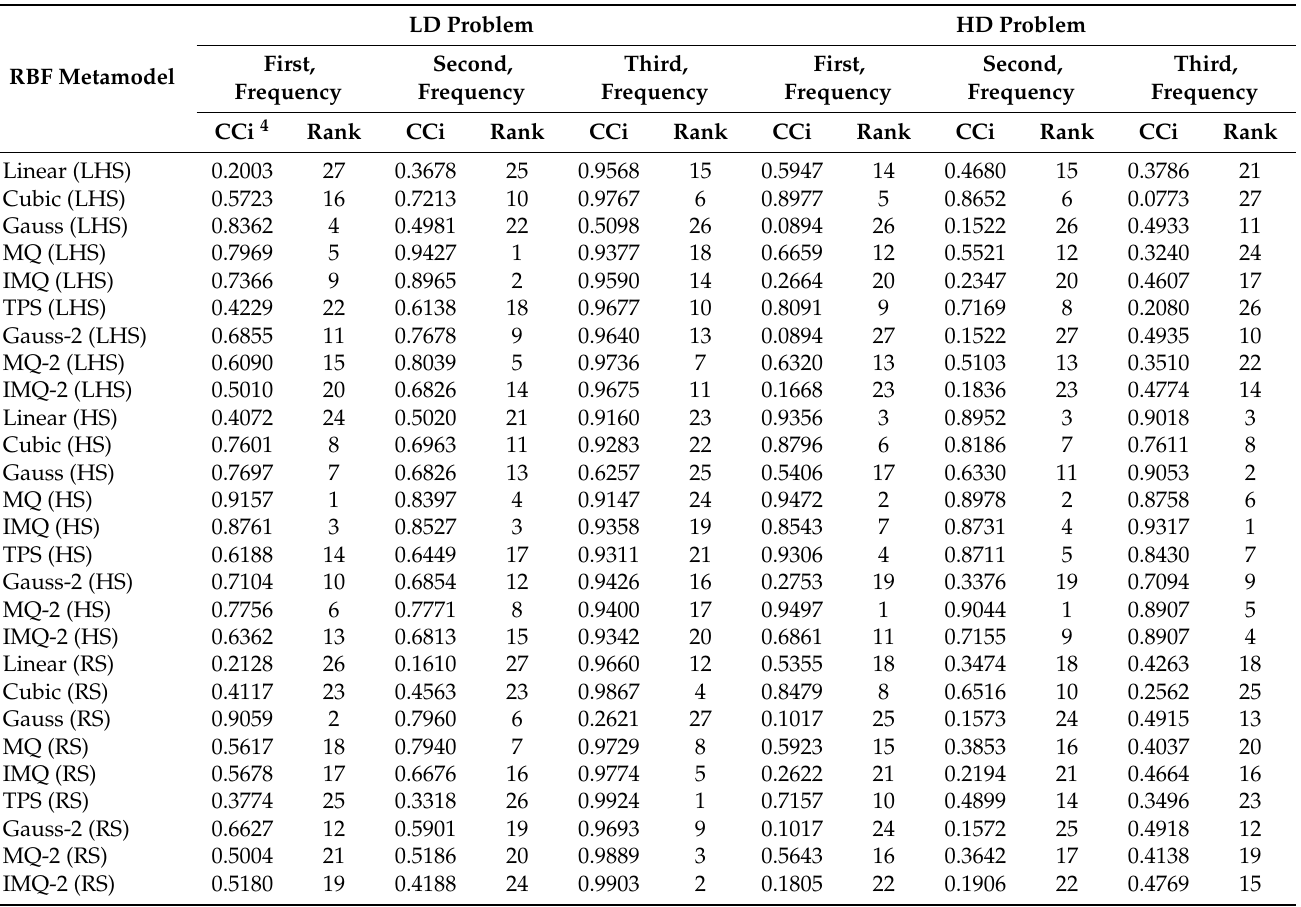
Table A4. Ranking of various RBF metamodels using